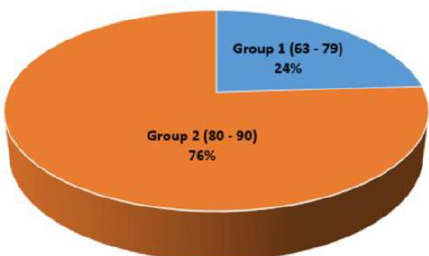
Figure 6. Percentage of trees according to the inclination angle at the TM Resorts